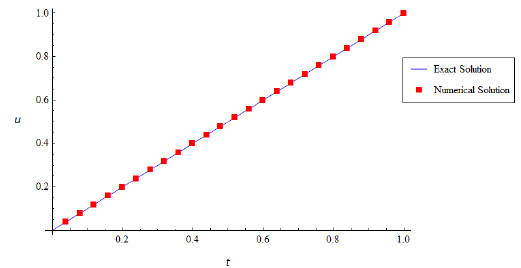
Figure 14. Graphical comparison of exact and numerical solution of Problem